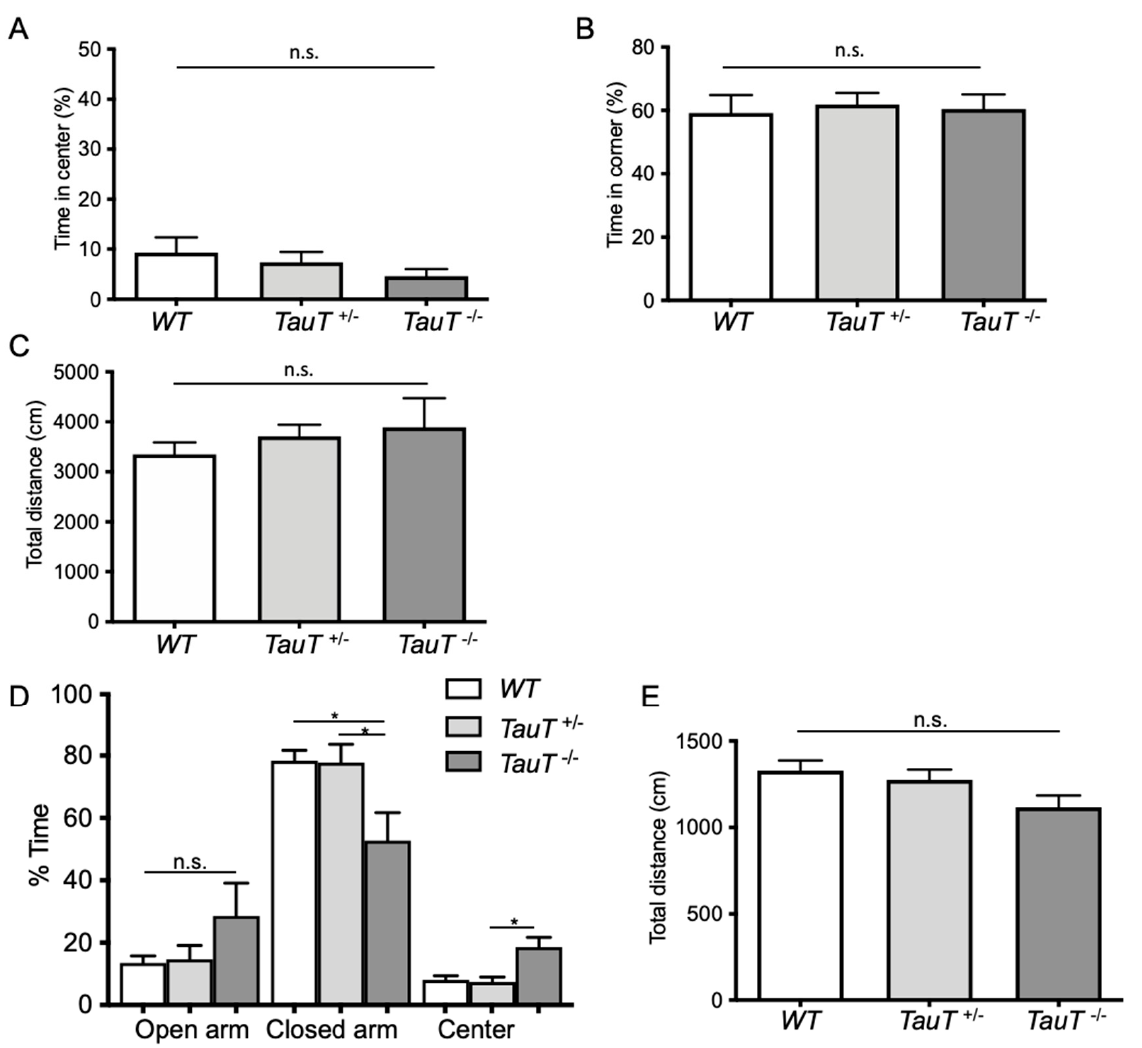
Figure 1. ( A – C ) In the open field test, mice were placed in the center of the open field apparatus and their movement was tracked for 10 min. The percentage of time spent in the center ( A ), percentage of time spent in the corner ( B ), and total distance moved in an open field ( C ) were measured for WT, TauT +/- , and TauT − / − mice. ( D , E ) In the elevated plus maze test, mice were placed in the center of the elevated plus maze and allowed to explore for 5 min. The percentage of time spent in the open arms, closed arms, and center (* p < 0.05, n.s. = not significant by Kruskal–Wallis test) ( D ) and total distance moved ( E ) in the elevated plus maze were measured. Error bars represent S.E.M.